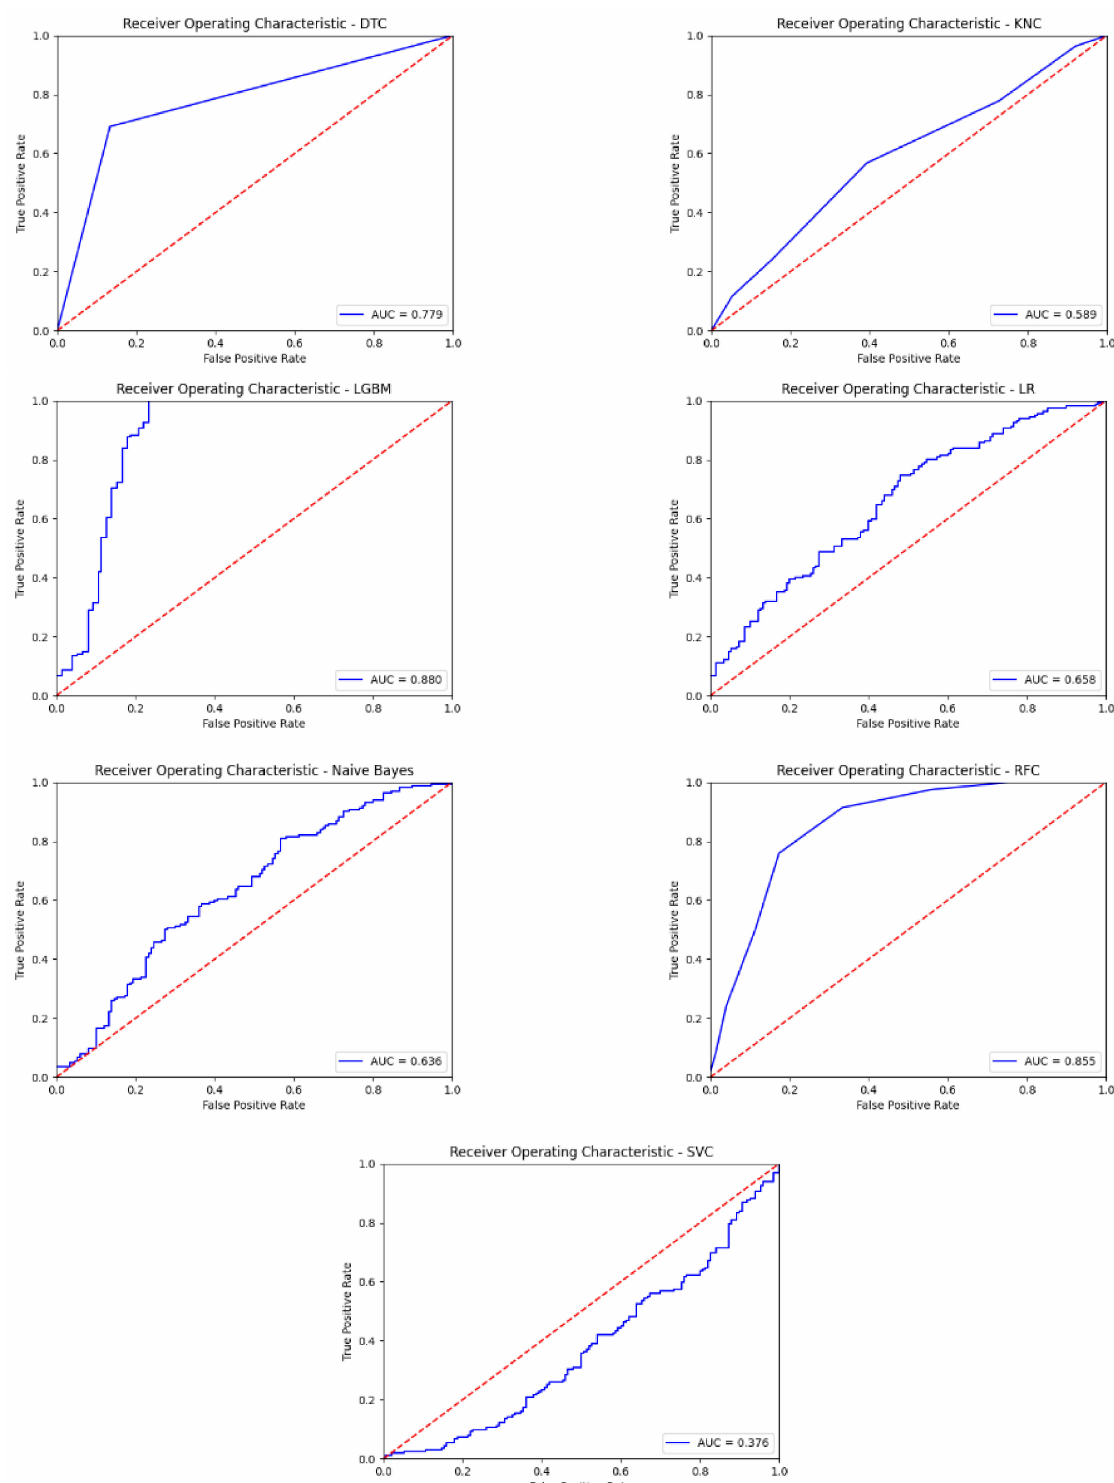
Figure 9. ROC curves obtained with seven different classification algorithms using 16 channels of EEG signals.